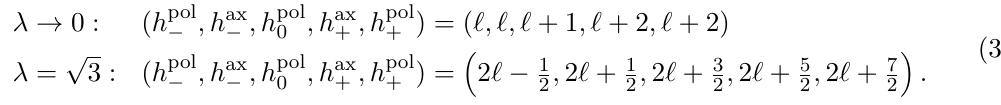
Figure 3 . Warping of the tower of conformal weights h ax AdS 2 × S 2 background in Einstein-Maxwell-dilaton theory, corresponding to g ax eq. (3.5). We find that a linear tower of axial modes occurs only for λ 2 = 0 or 3 (red vertical lines), corresponding respectively either to four-dimensional Einstein-Maxwell theory or to the KK reduction of five-dimensional Einstein